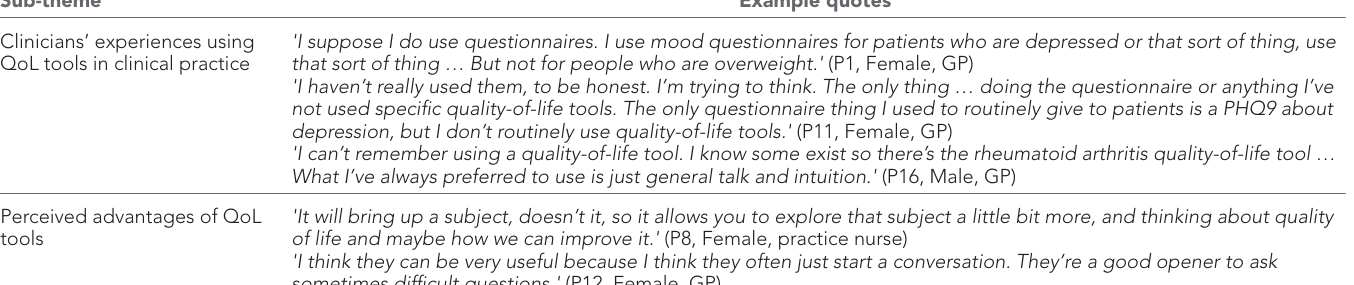
Table 2 Supporting quotes for the 'Views about QoL tools in clinical practice' theme Sub- theme Example quotes